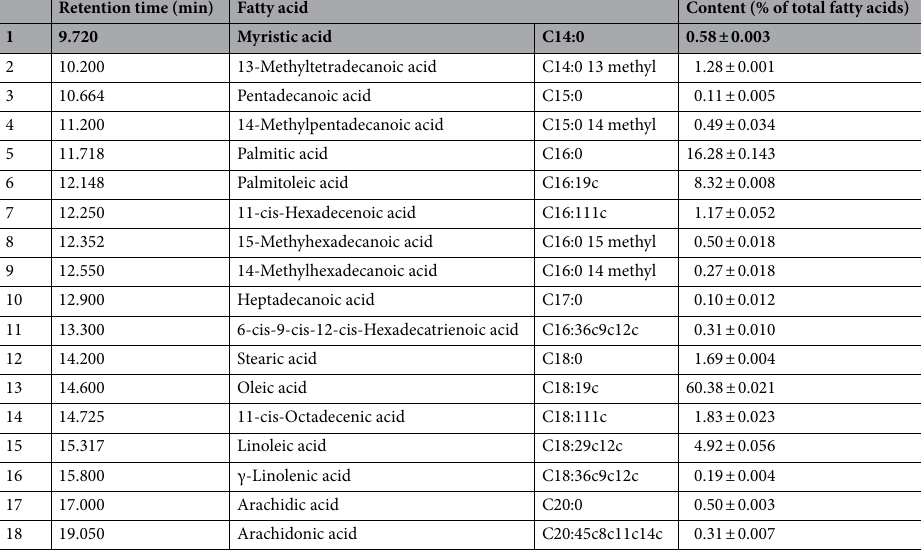
Table 2. Fatty acid profile of Protaetia brevitarsis seulensis larvae; values are expressed as a mean value ± SD.